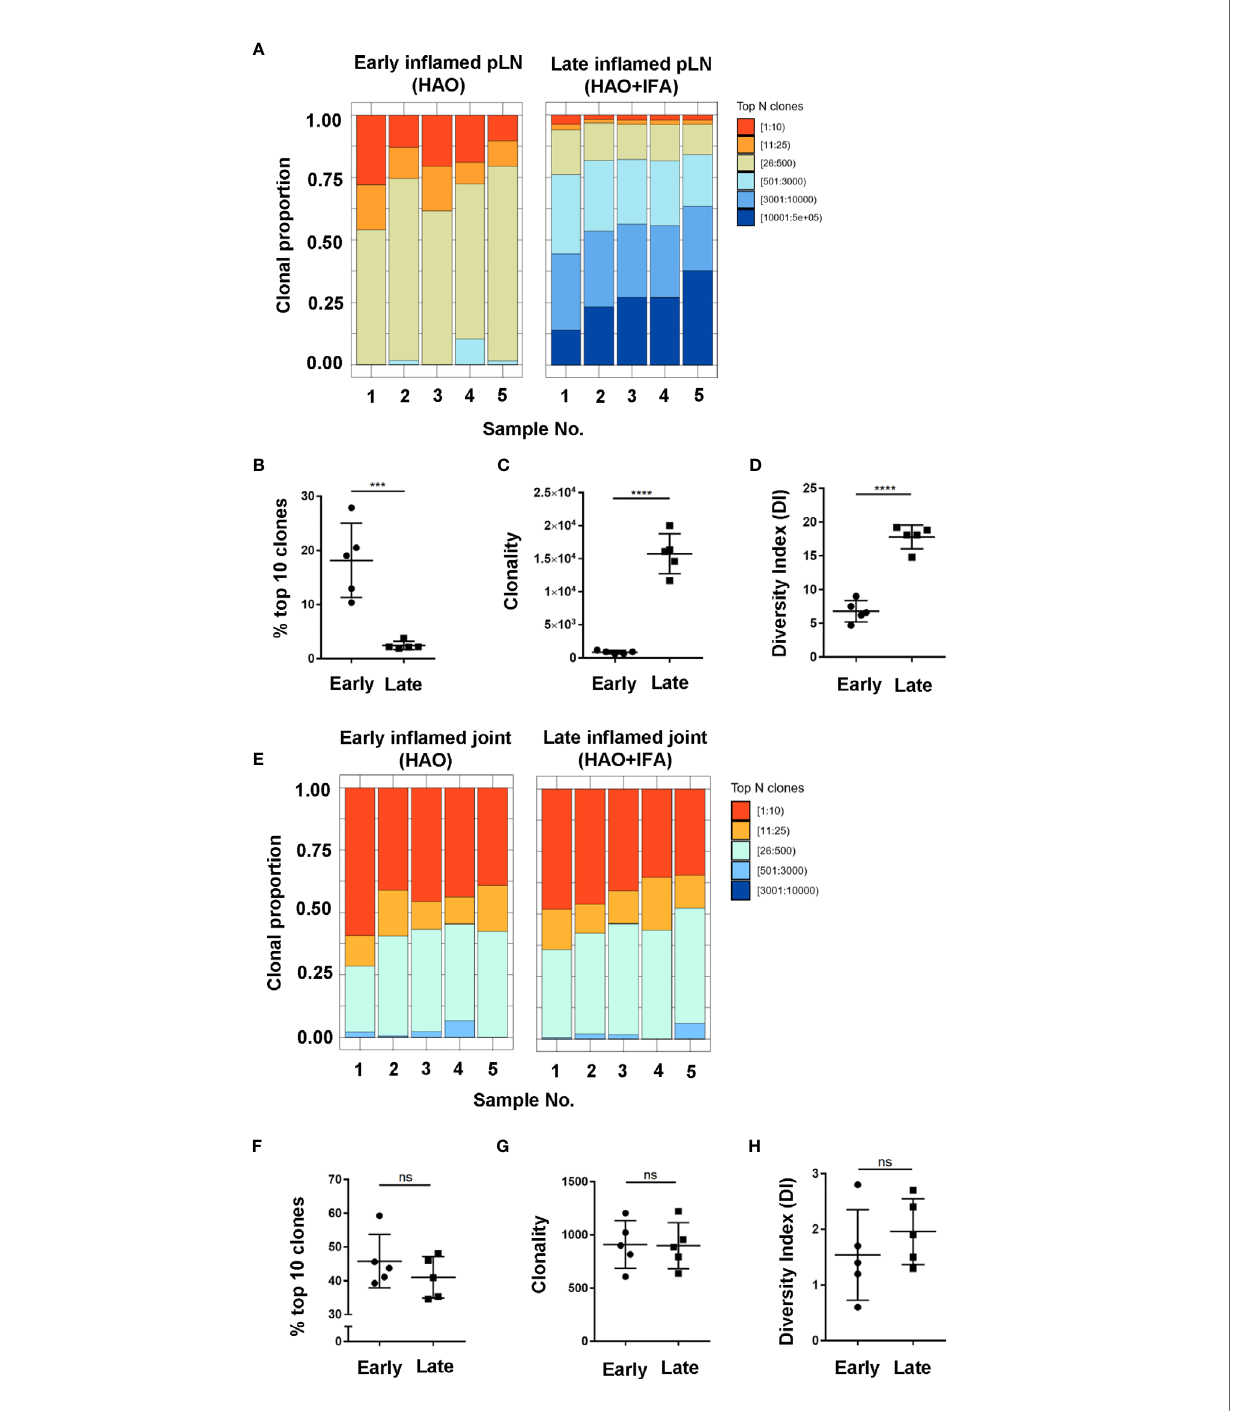
FIGURE 4 | Characterisation of antigen experienced endogenous CD4 T cell repertoires in in fl amed pLNs and joints at the early and late phases. Proportion of the top 10 most frequently occurring clones, followed by the next 25, 500, 3000, 10,000, and 100,000 most frequent clones contributing to the endogenous antigen experienced CD4+ T cell repertoire in (A) in fl amed pLNs at the early and late phases, and (E) in fl amed joints at the early and late phases. (B , F) percentage contribution of the top 10 most frequently occurring clones in (B) in fl amed pLNs and (F) in fl amed joints at the early and late phases. (C , G) clonality, represented as the number of unique CDR3 b DNA sequences, in (C) in fl amed pLNs, and (G) in fl amed joints at the early and late phases. (D , H) diversity indices of (D) in fl amed pLNs, and (H) in fl amed joints at the early and late phases. Data is representative of mean ± SD with each point representing individual experimental mice. Data represents 1 experiment with n=5 for both the early and late phase groups. Groups were compared using unpaired Student ’ s t-test. Stars represent the following p values: ***<0.001; ****<0.0001; ns, not signi fi